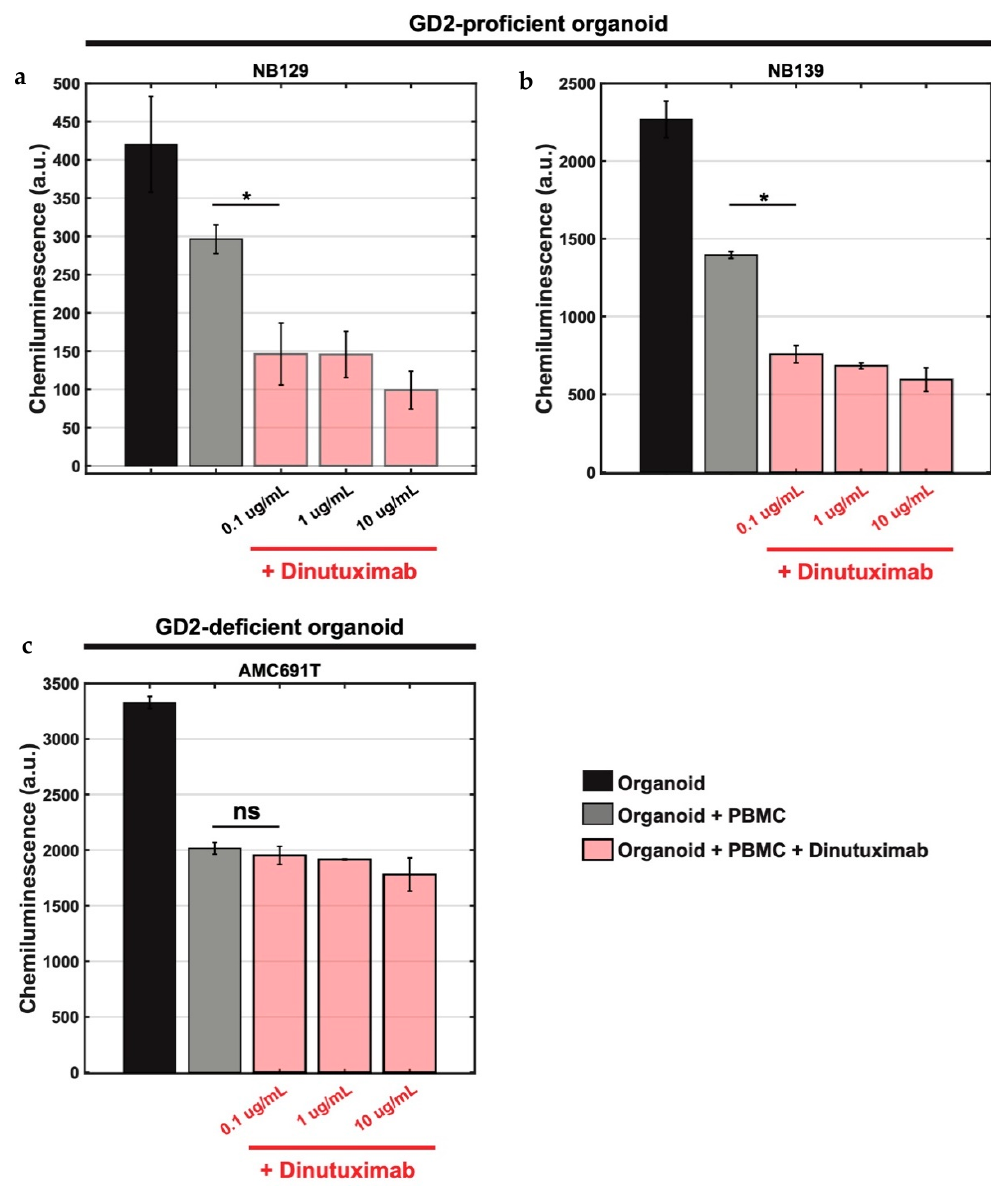
Figure 5. Effect of Dinutuximab treatment on neuroblastoma cells cocultured with PBMCs. Chemiluminescence-based cell viability was measured using the ADCC luciferase assay. ( a , b ) The viability of neuroblastoma cells (black column) were compared with cocultured neuroblastoma cells with PBMCs (grey column, used as negative control) in the presence of dinutuximab, an FDA-approved monoclonal antibody targeting GD2 antigen. Tumour cells were exposed for 4 h to 0.1, 1 and 10 ug/mL of dinutuximab in GD2-proficient organoid lines NB129 and NB139. ( c ) Similar to a and b, the neuroblastoma organoids (cocultured with PBMCs) were exposed for 4 h to 0.1, 1 and 10 ug/mL of dinutuximab in GD2-deficient organoid lines AMC691T cells. All experiments were performed in triplicate. Error bars represent standard deviation values. * p value is less than